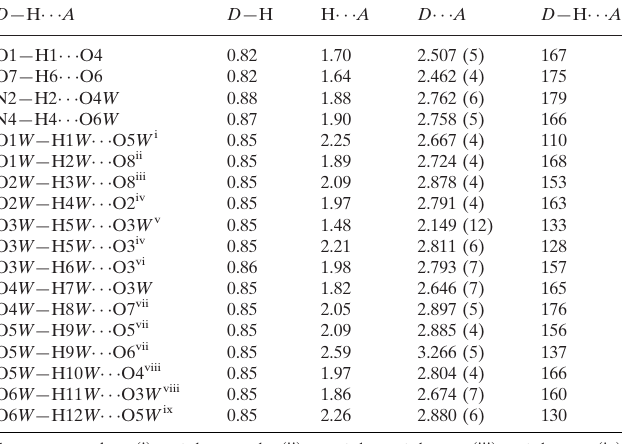
Hydrogen-bond geometry (A˚ , (cid:4)